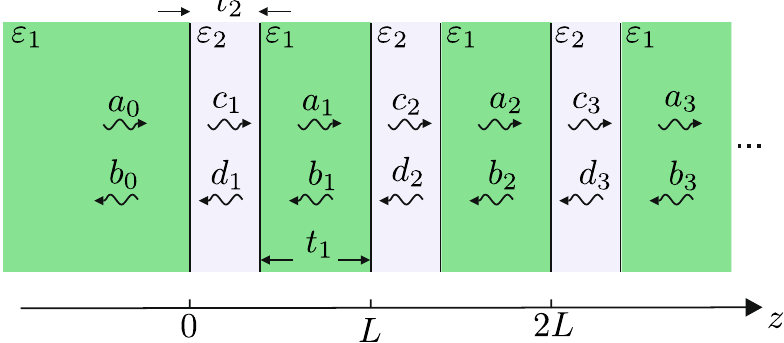
Figure 3. Schematics of the homointerface geometry used in the transfer-matrix method. The ε 1 medium extends from left infinity up to the interface at z = 0, after which the superlattice is formed by periodically repeating the unit cell comprising a ε 2 and ε 1